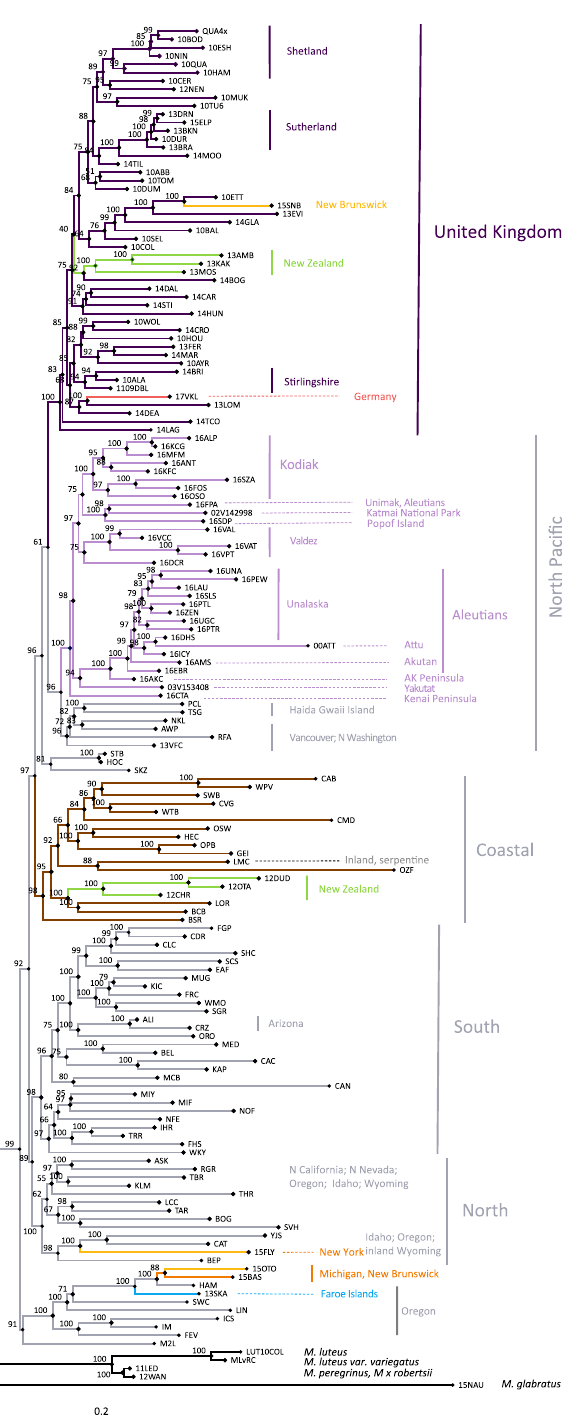
Fig. 2 Phylogenetic reconstruction of studied Mimulus . Maximum likelihood phylogenetic reconstruction of the relationship between studied Mimulus guttatus populations, and including populations from M. luteus (LUT10COL, UK) , M. luteus var. variegatus (MLvRC, Chile) M x robertsii (12WAN) and M. peregrinus (11LED). The tree is rooted using a population of M. glabratus from Michigan